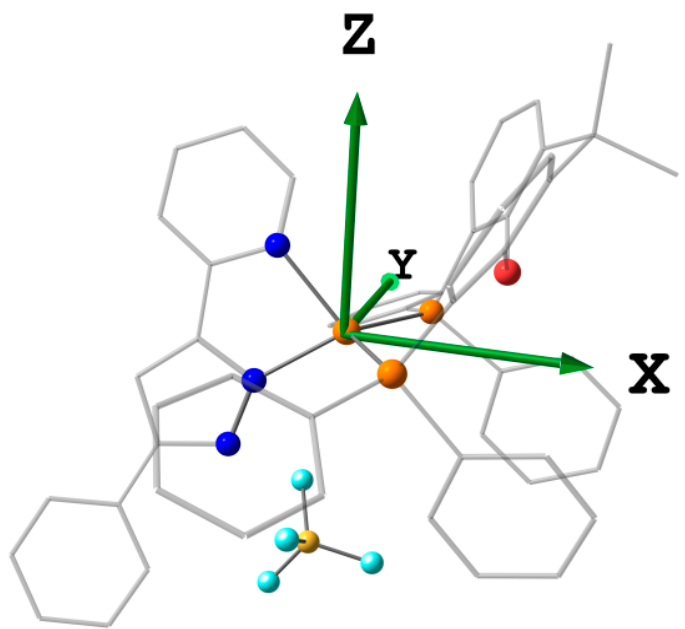
Figure 3. Principal axes used for buried volume steric maps. The Cu atom is the origin of coordi- nates, the XY plane is the Cu–P–P plane, and the X -axis is set to pass through the midpoint of P–P atoms.